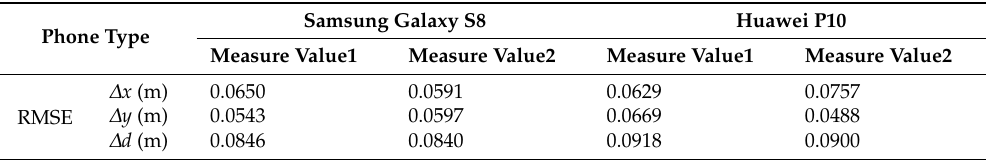
Table 4. Root mean square error (RMSE) of positioning